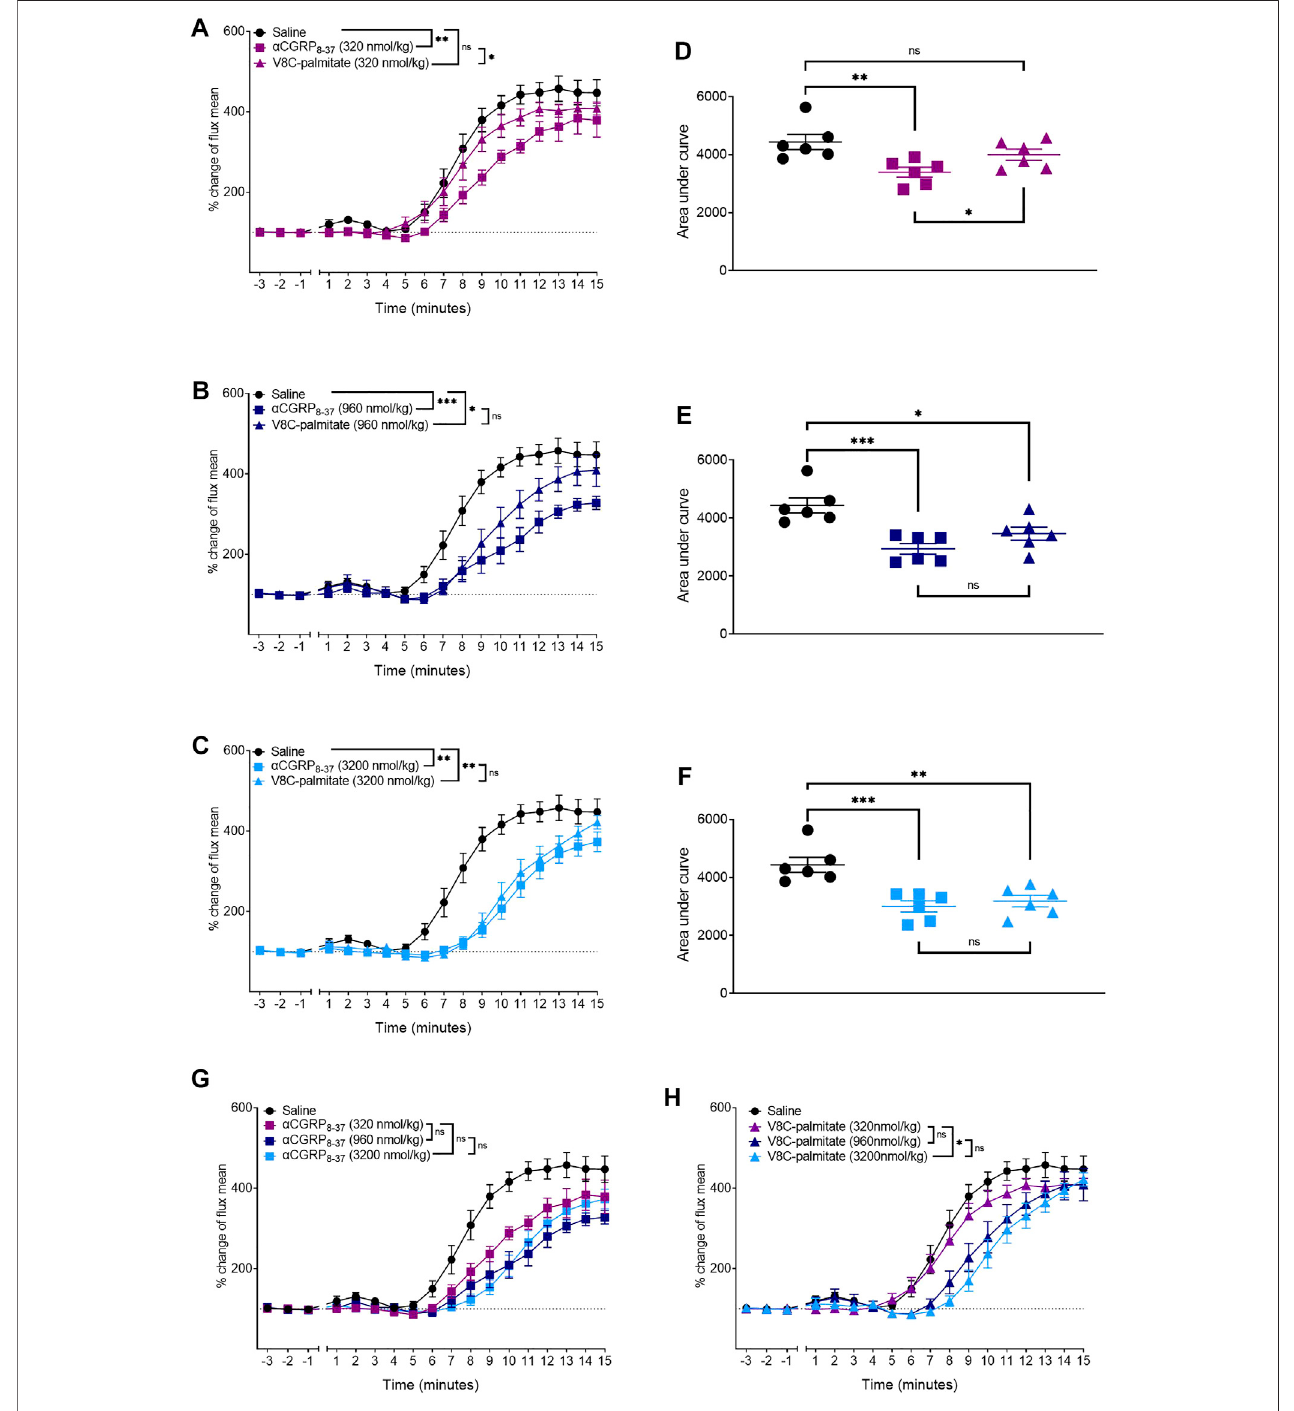
FIGURE 8 | Dose-dependent effects of α CGRP 8-37 and V8C-palmitate on CIDV in male mice. Peptides were administered at doses of 320 nmol/kg (A,D) , 960 nmol/kg, (B,E) or3,200 nmol/kg (C,F) .Combineddatafor α CGRP 8-37 andV8C-palmitateareshownin (G,H) ,respectively.ns p > 0.05,* p < 0.05,** p < 0.01,*** p < 0.001. Each treatment group comprised six mice with corresponding saline controls.